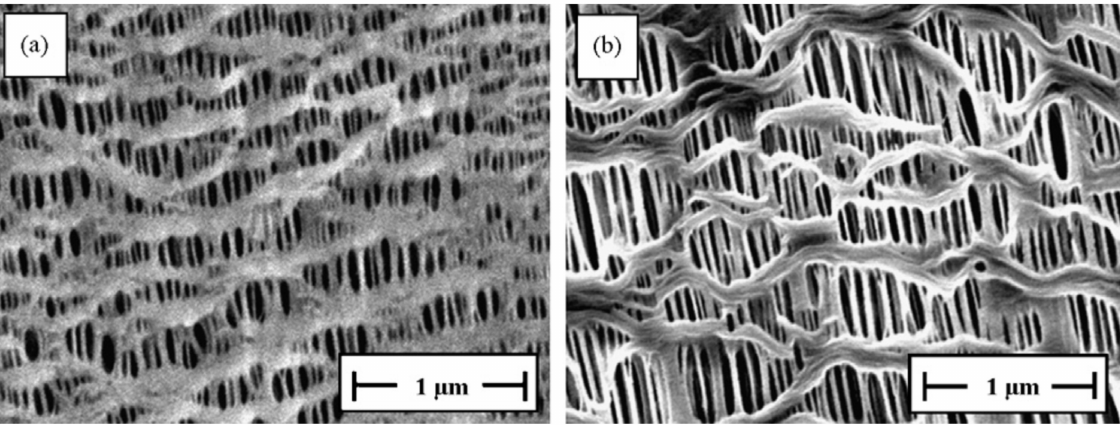
Figure 5. SEM micrographs of the surface of microporous membranes (20 m thick): ( a ) PP and ( b ) HDPE; DR = 90, H-AFR, cold stretching of 55%, followed by hot stretching of75%. Provided with permission by Elsevier.